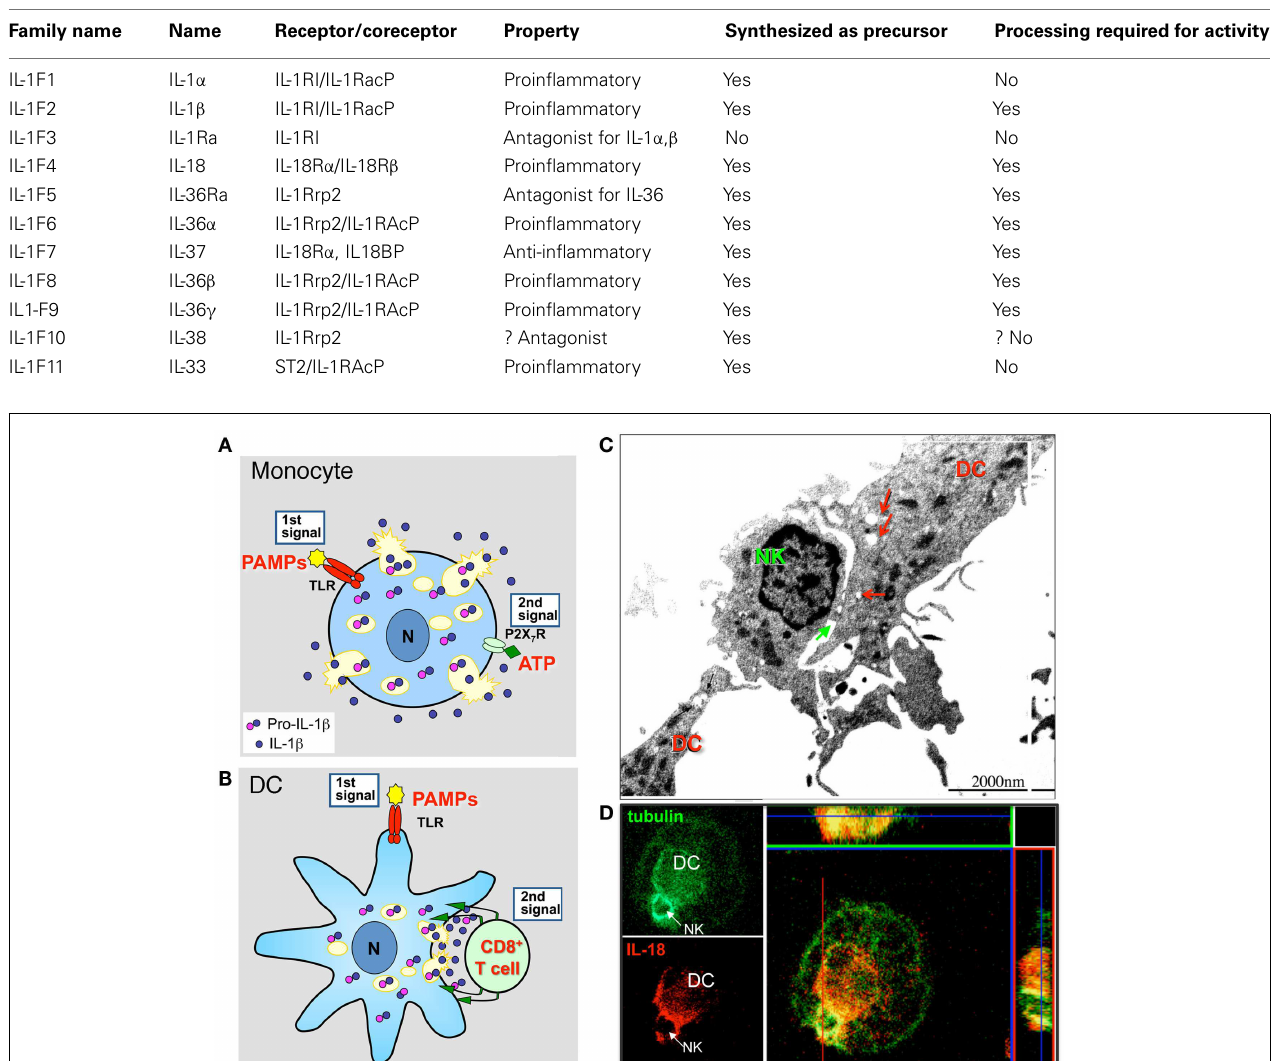
FIGURE 1 | Lysosome exocytosis allows diffuse and polarized secretion of IL-1 β and IL-18 . (A) Models of non-polarized secretion of IL-1 β .TLR agonists (e.g., PAMPs) induce monocytes/macrophages to actively synthesize pro-IL-1 β that accumulates into the cytosol and in part into secretory lysosomes. A second extracellular soluble signal (e.g., ATP) triggers generalized lysosome exocytosis (Andrei et al., 1999). A similar mechanism accounts for IL-18 secretion (Perregaux et al., 2000). (B) Models of polarized (lower panel) secretion of IL-1 β . In DCs, a first maturative stimulus (e.g.,TLR triggering), induces pro-IL-1 β synthesis.The second signal is provided by antigen specific T cells that induces a [Ca 2 + ] i rise, followed by recruitment of IL-1 β -containing secretory lysosomes toward the interactingT cell, and by exocytosis restricted